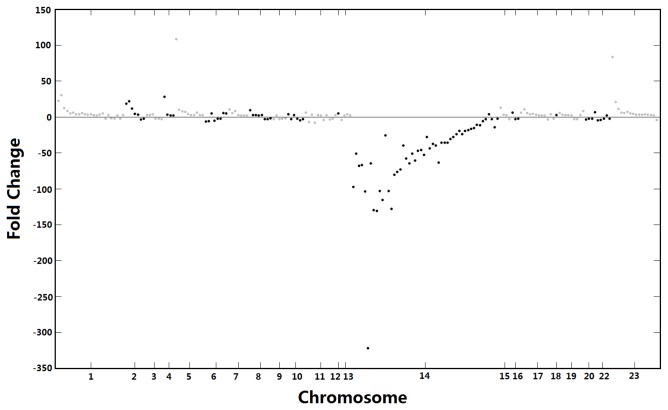
Manhattan plot of the chromosomal distribution of differentially expressed miRs.The x-axis represents the 23 human chromosomes end-to-end; the y axis shows the expression changes of individual miRs in K562/ADM cells based on miR-seq profiling. Only differentially-regulated miRs showing 2-fold or greater changes in their expression are shown. Grey dots represent miRs on chromosomes 1, 3, 5, 7, and 9 etc. while black dots are miRs on even numbered chromosomes. No miR with a 2-fold or greater fold change mapped to chromosome 21.